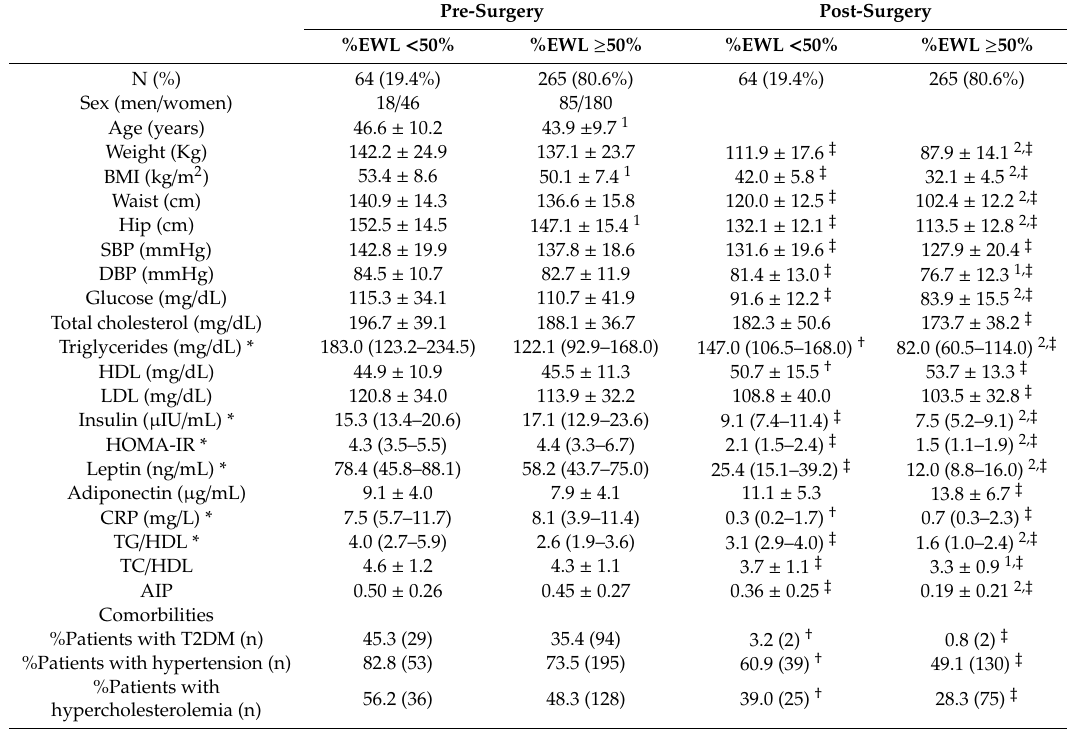
Table 2. Characteristics of patients with morbid obesity at baseline and one year after bariatric surgery, classified according to the percentage of excess weight loss